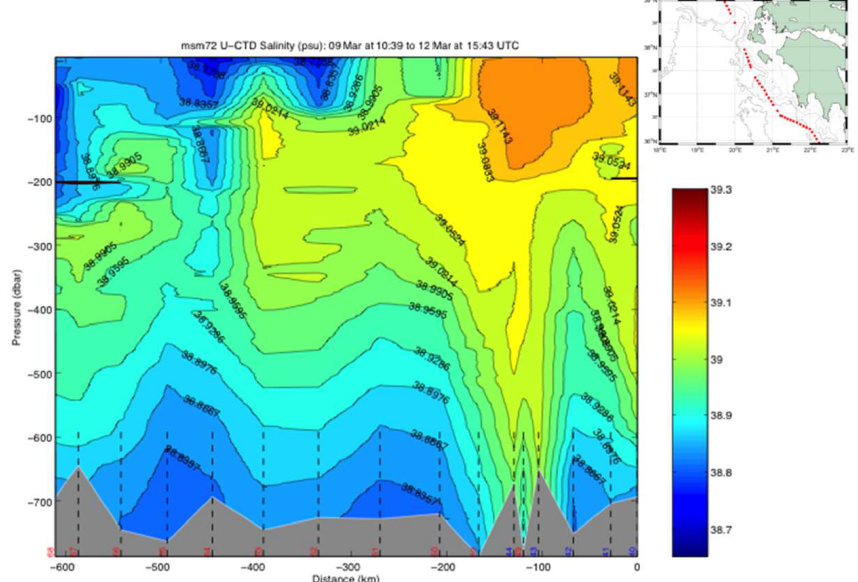
Figure 3. The uCTD salinity transect; the location is shown in the inset.